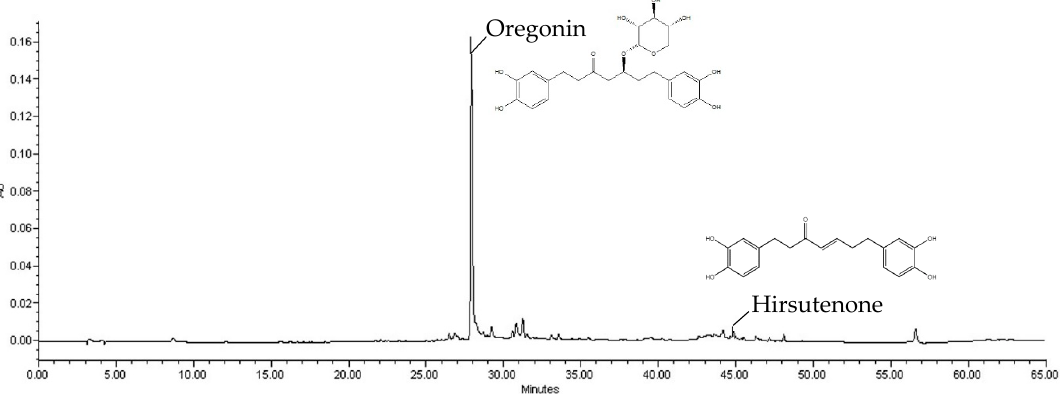
Figure 3. High-performance liquid chromatography (HPLC) result of Alnus sibirica extract (ASex) and its major compounds.